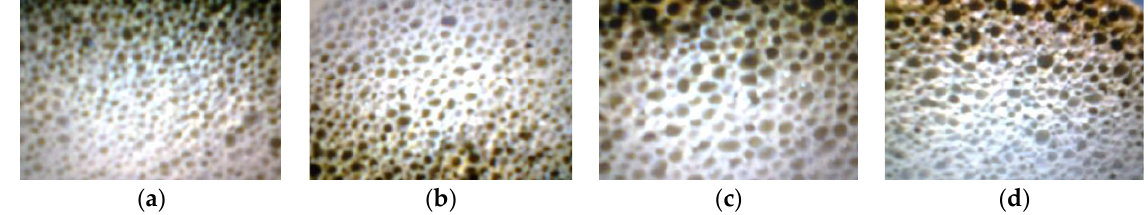
Figure 3. Microstructural images of cellular concrete specimens: ( a ) variant 1; ( b ) variant 2; ( c ) variant 3; ( d ) variant 4.